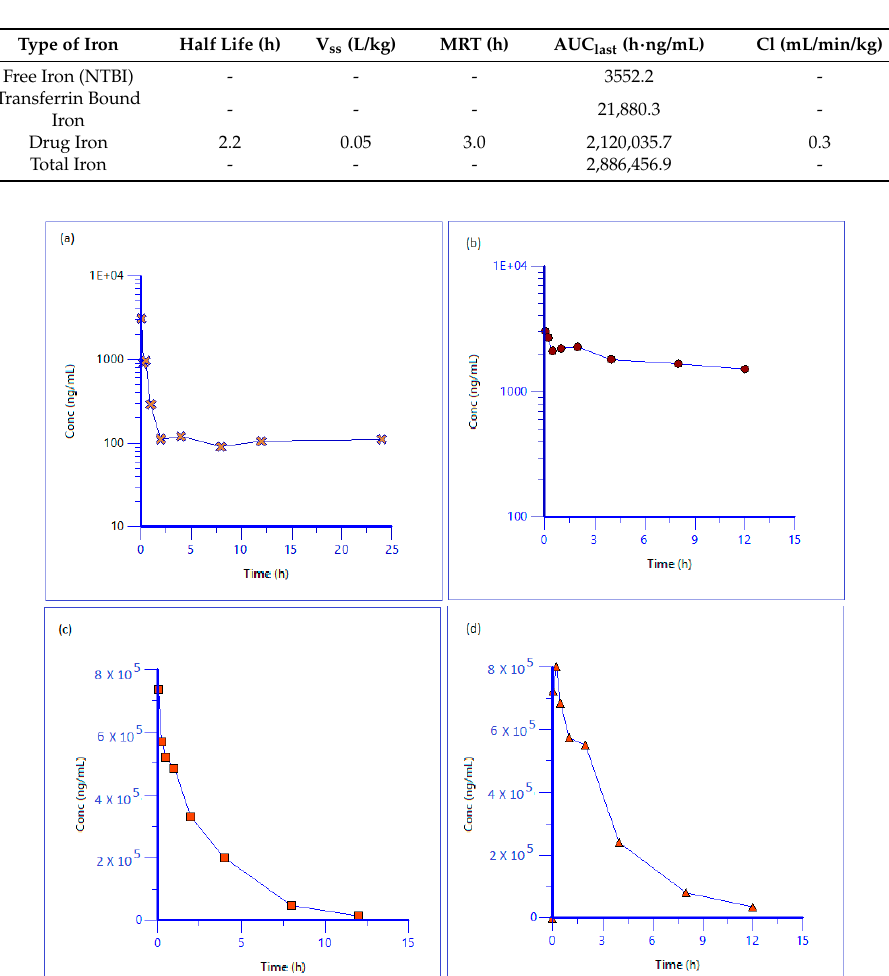
Figure 4. Chelation effect of bleomycin on ( a ) Iron colloidal drug; ( b ) Transferrin bound iron.